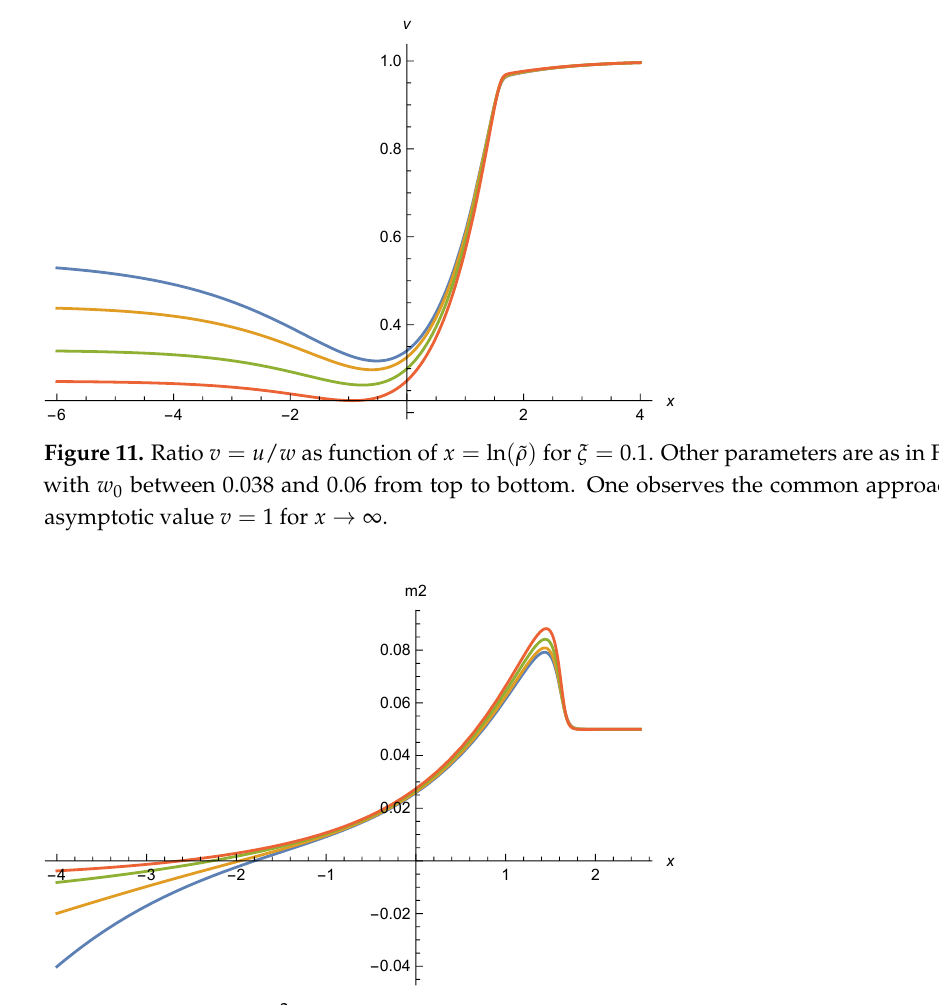
Figure 12. Mass term ˜ m 2 ( x ) with parameters as in Figure 10, with w 0 between 0.038 and 0.06 from bottom to top on the left side of the